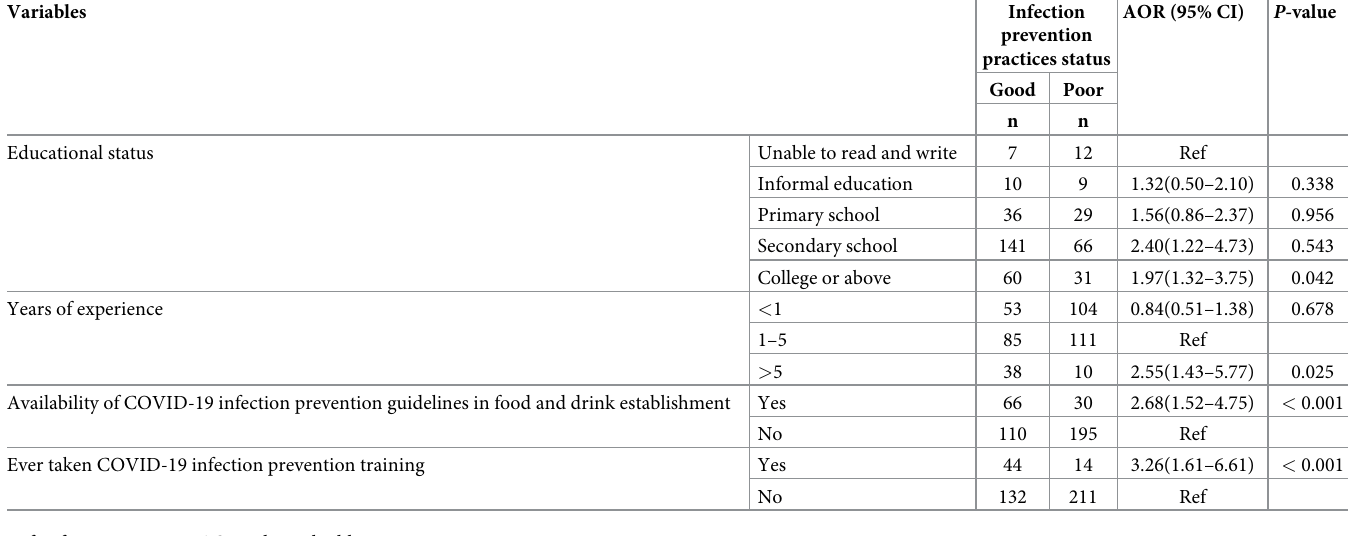
Table 7. Multivariable analysis of factors associated with COVID-19 infection prevention practices among food handlers at food and drink establishments in Dessie City and Kombolcha Town, Northeastern Ethiopia, July–August 2020.